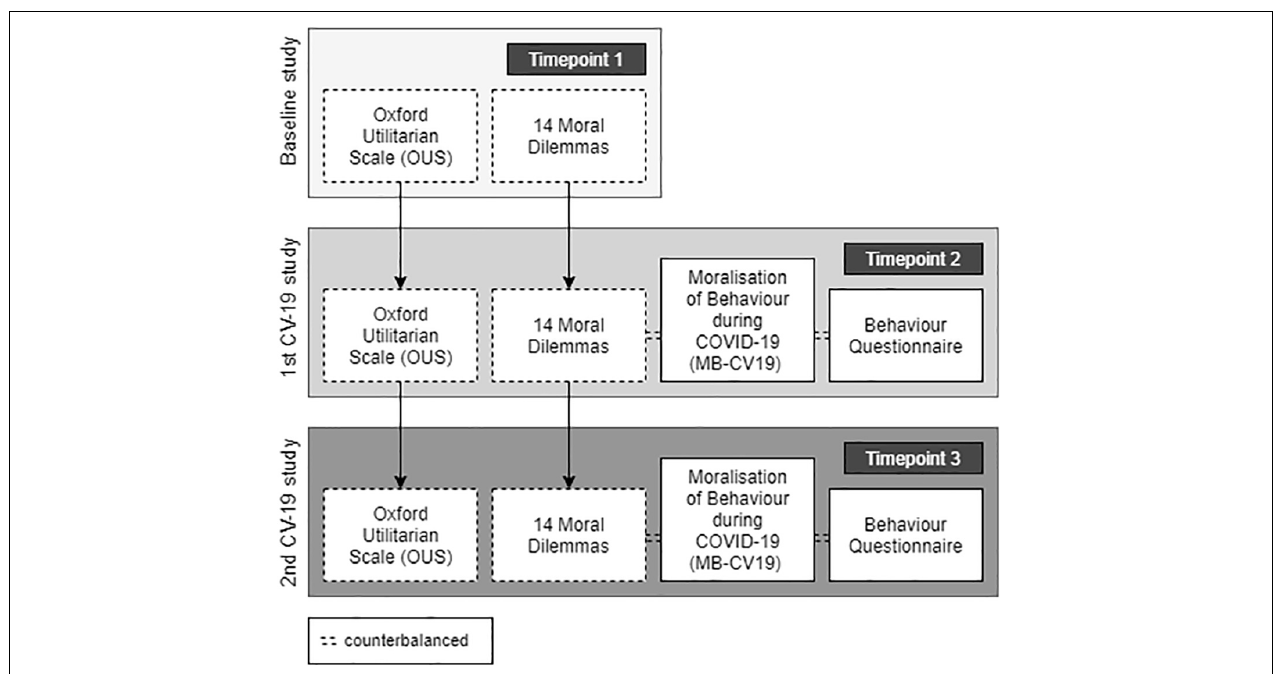
FIGURE 2 | Experimental designs of baseline and COVID-19 studies. Participants who took part in the COVID-19 studies (timepoint 2, timepoint 3) had previously taken part in a baseline study (timepoint 1). Participants responded to the OUS and moral dilemmas at all timepoints (arrows indicate longitudinal comparison).